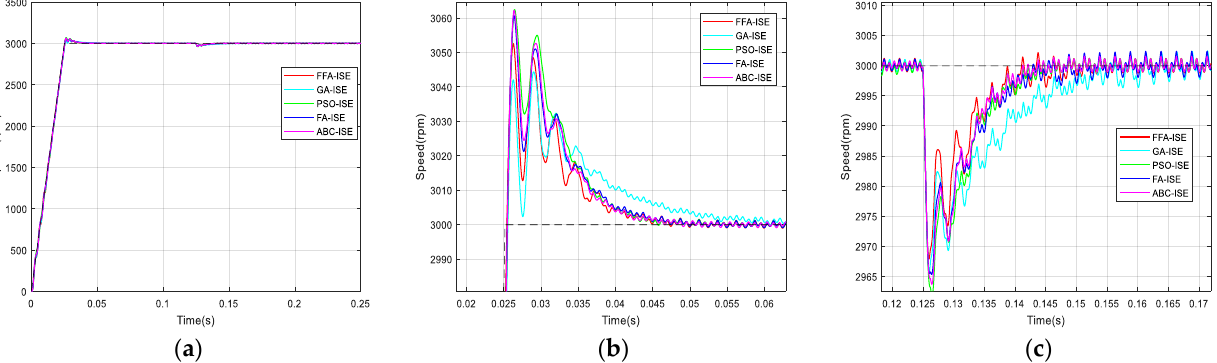
Figure 14. Comparison of speed responses with different algorithms using ITAE criterion: ( a ) original; ( b ) and ( c ) zoomed version.